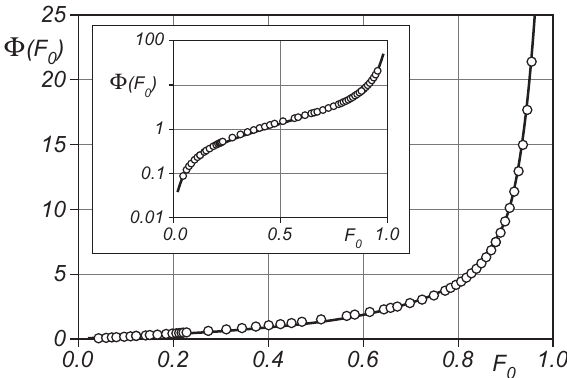
Figure 2. Plot of Φ ( F 0 ) as a function of F 0 . White circles denote the results of the 0D model, the black line is the approximation (10). The inset shows the same plot, with Φ ( F 0 ) on the log-scale.